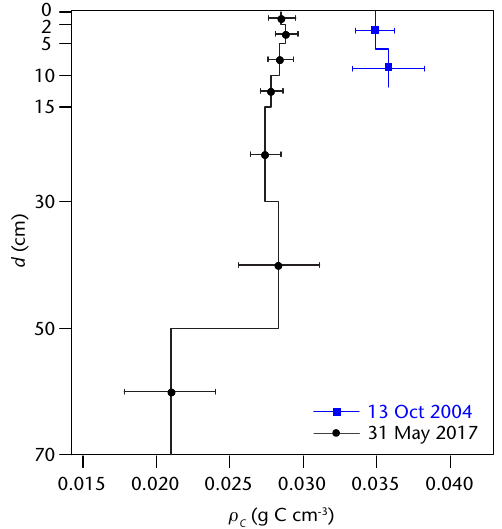
Figure 3. Average soil carbon density ( ρ c ) for different depth layers on 13 October 2004 and 31 May 2017. Error bars show standard